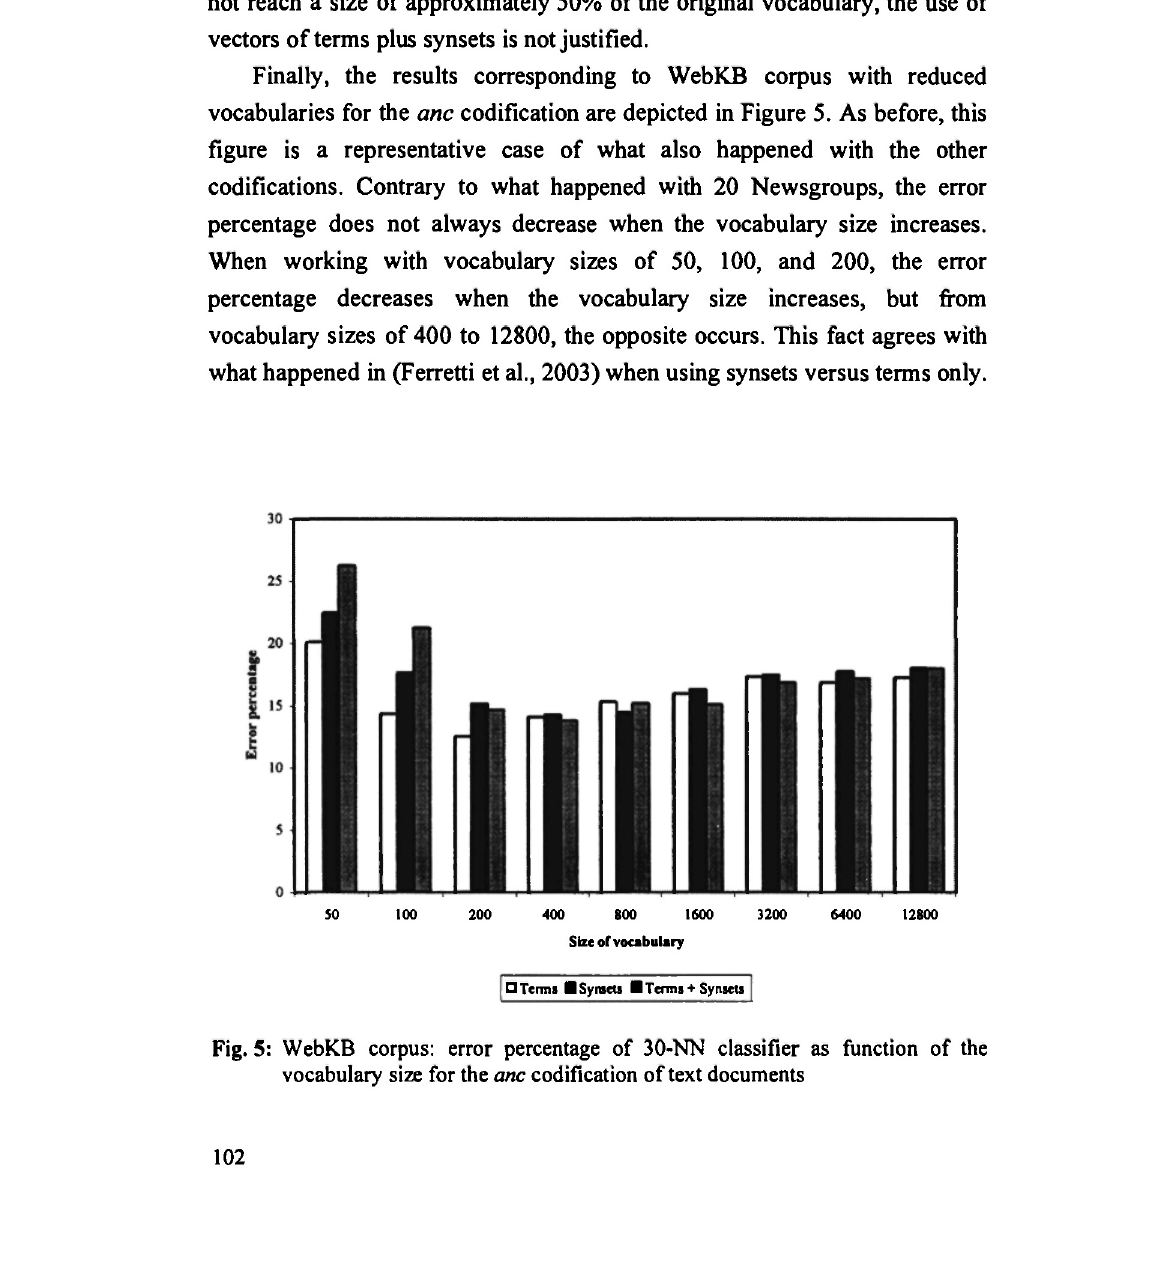
Fig. 5: WebKB corpus: error percentage of 30-NN classifier as function of the vocabulary size for the anc codification of text